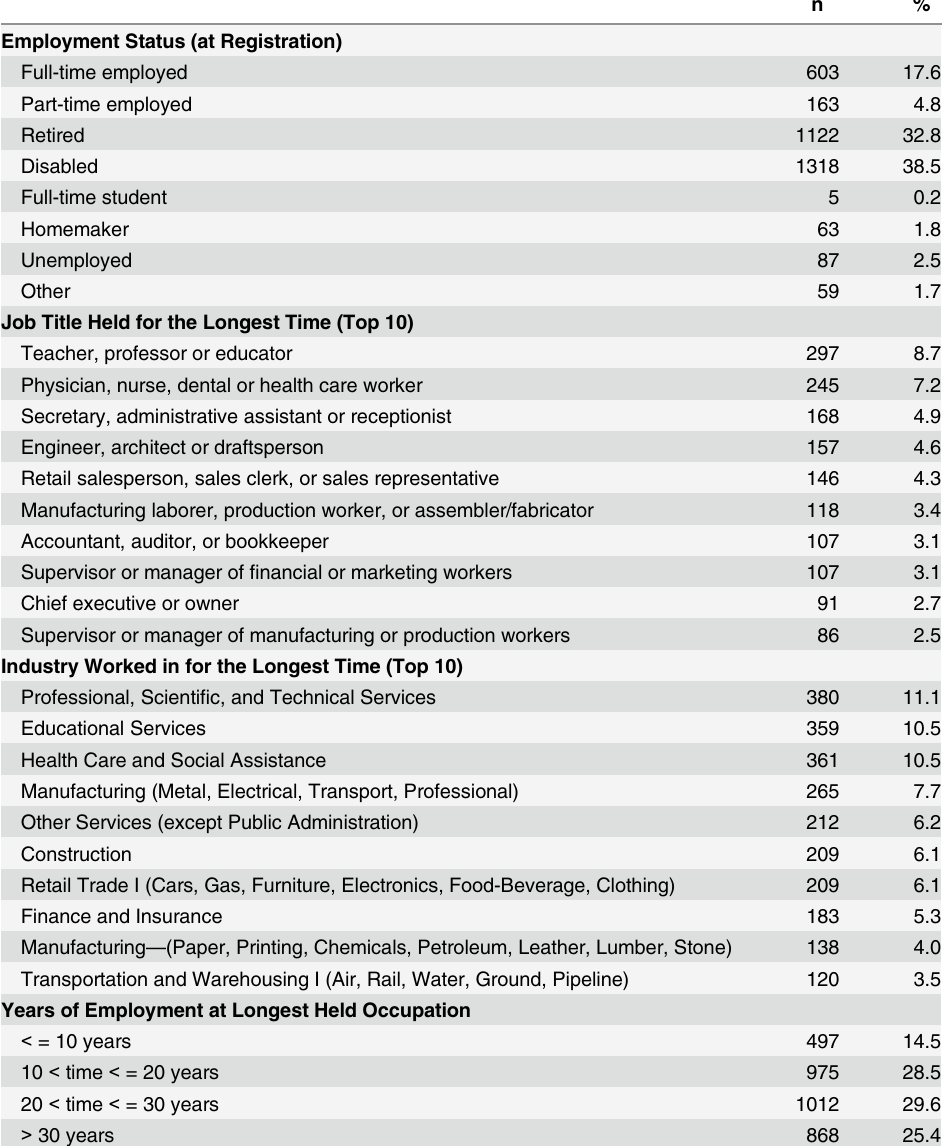
Table 4. Occupational History of Adults with ALS (October 19, 2010 – December 31,